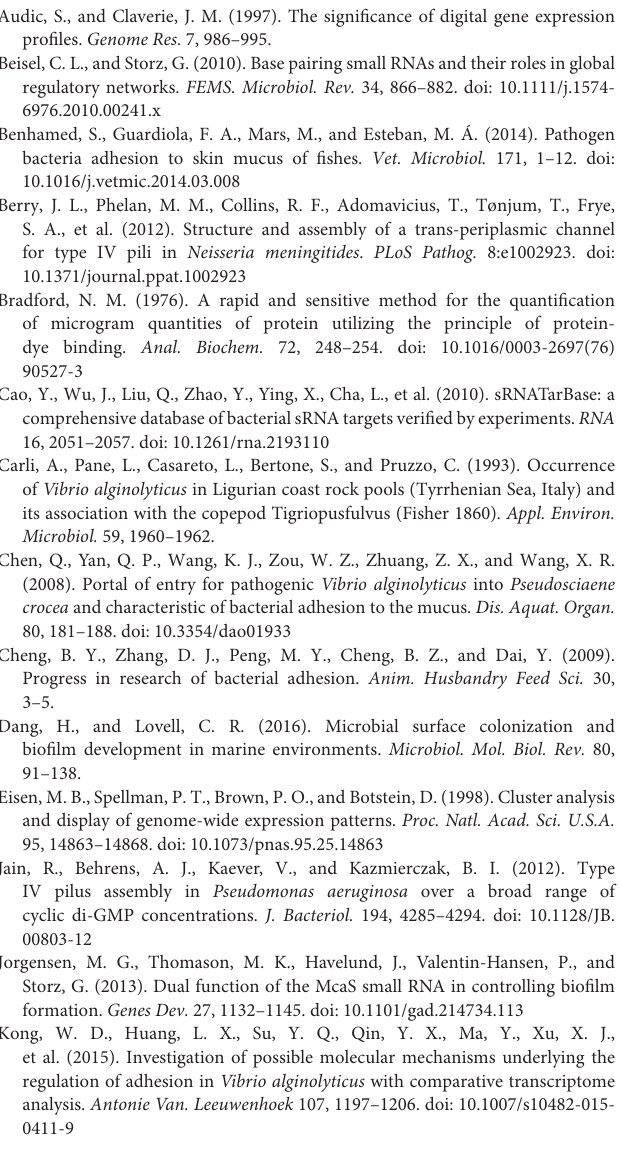
TABLE S2 | ncRNA sequences. TABLE S3 | Location of candidate ncRNAs. TABLE S4 | Reads per kb per million reads (RPKM) of candidate ncRNAs. TABLE S5 | Differential expression of ncRNAs under stress treatments. TABLE S6 | Alignment based on similarity of sequences and consensus secondary structure of commonly changed ncRNAs. TABLE S7 | Identification of target genes of commonly changed ncRNAs. TABLE S8 | Gene ontology analysis of target genes of commonly changed